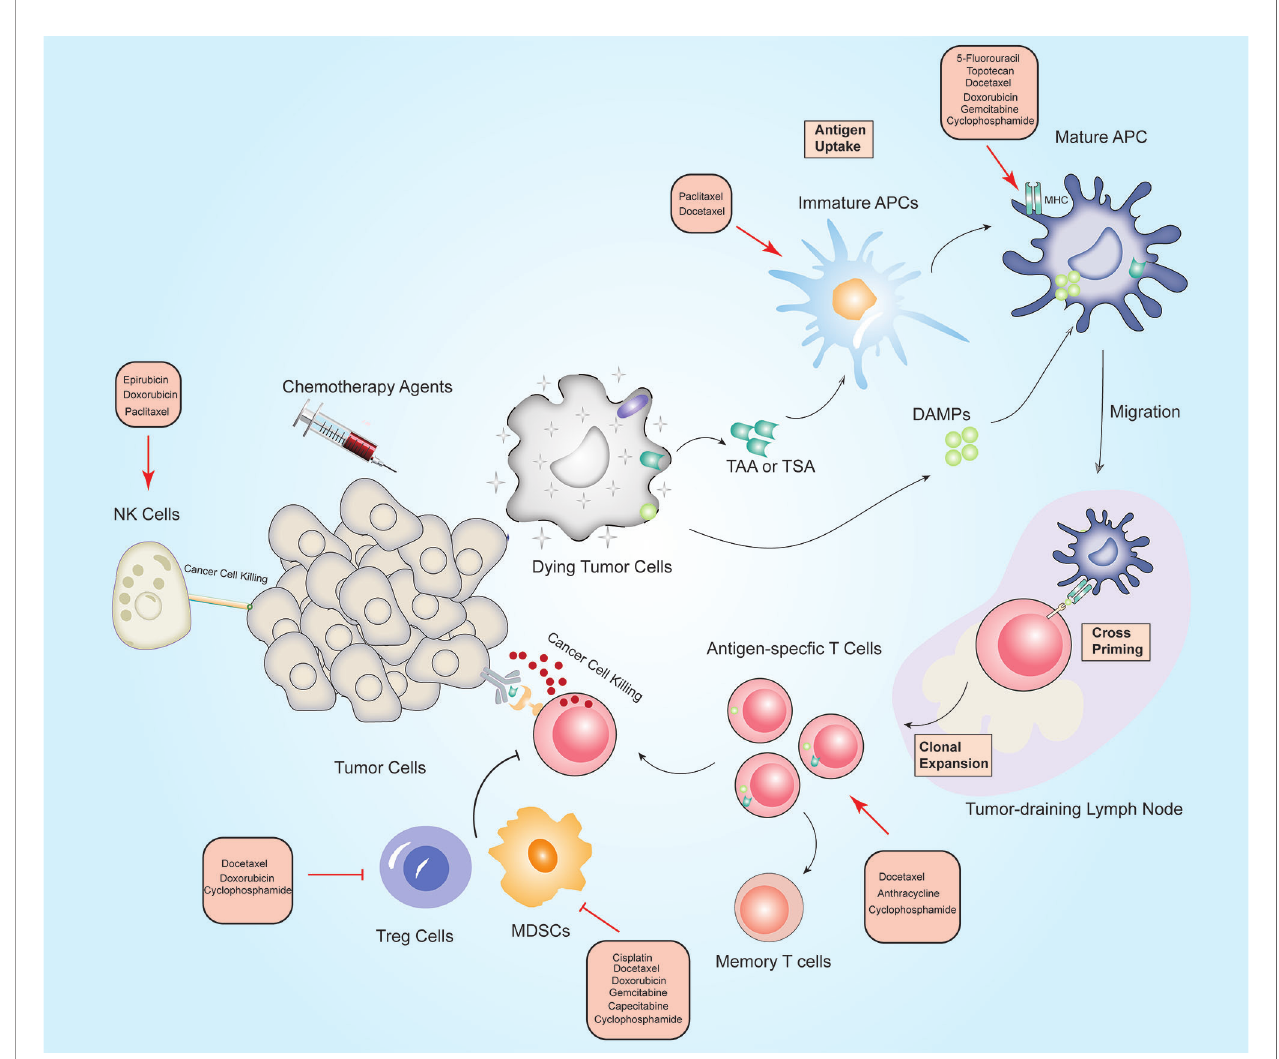
FIGURE 1 | Overview of the immunostimulatory properties of chemotherapy in breast cancer. On-target effects: When tumor cells are exposed to chemotherapeutic drugs, TAA, TSA and DAMPs release by dying tumor cells are engulfed by immature DCs, which promotes APCs maturation. Archived antigen-bearing APCs then migrate to the tumor-draining lymph node, where APCs cross-prime to T cells. Thereafter, antigen-speci fi c T cells undergo clonal expansion, and at least some of them differentiate into memory T cells. Activated T cells then recognize tumor cells and mediate cytotoxic killing of tumor cells. Off-target effects: Chemotherapeutic drugs can activate immune effector cells including natural killer (NK) cells, dendritic cells (DCs), and cytotoxic T cells, and depletion of immunosuppressive cells including Treg cells, M2 macrophages and (myeloid-derived suppressor cells) MDSCs. Red arrows indicate an increased effect and red fl at ended lines represent an inhibitory effect. The text boxes near the arrows list the chemotherapy agents that elicit immunomodulatory effects in